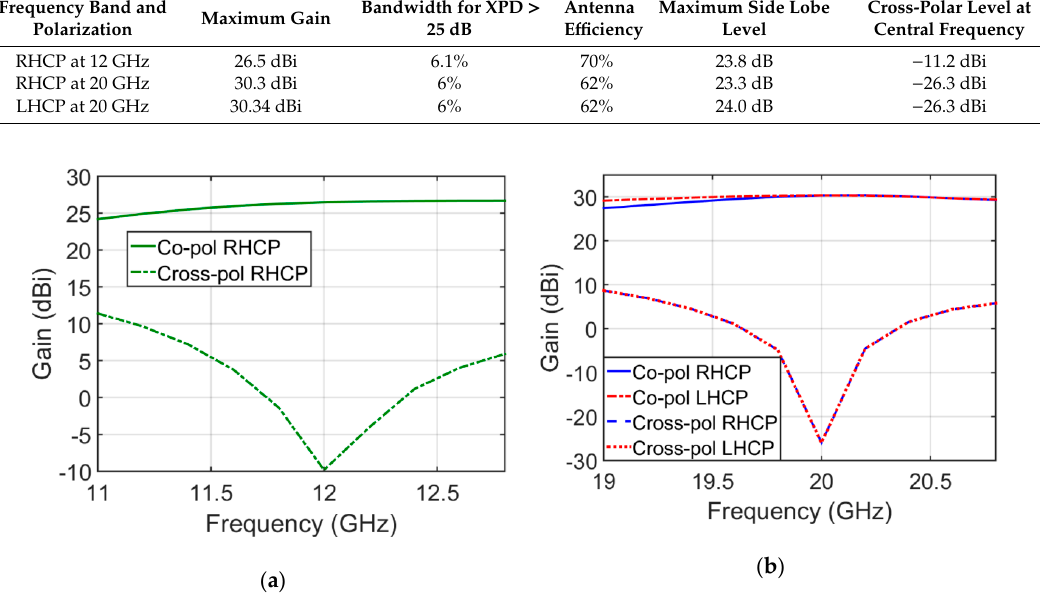
Figure 9. ( a ) Maximum of simulated gain versus frequency for frequencies closer 12 GHz. ( b ) Maximum gains versus frequency for frequencies closer 20 GHz.